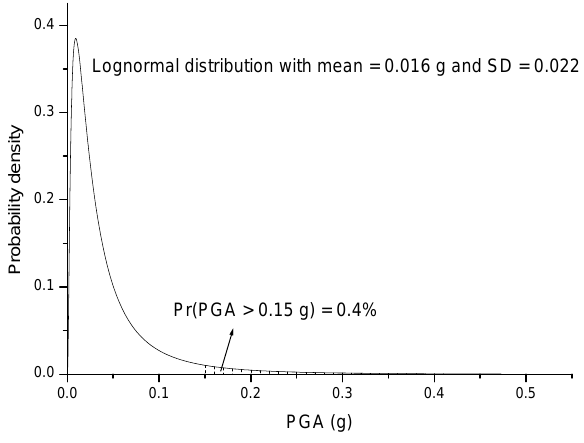
Fig. 6. The expected PGA distribution at the study site, conditional to a random M L > 6.0 event within 200km from the site.